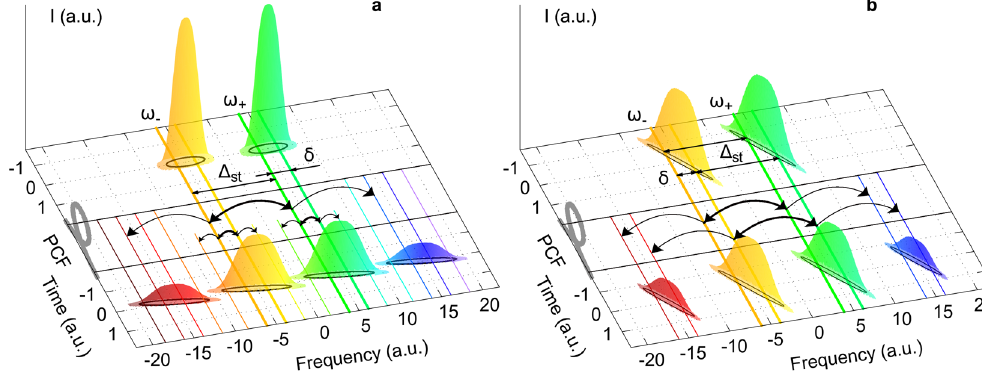
Figure 1. Nonlinear mixing in a PCF of two solitons ( a ) and two equally chirped dissipative solitons ( b ) with frequency separation Δ st , each of which consisting of laser modes with separation δ